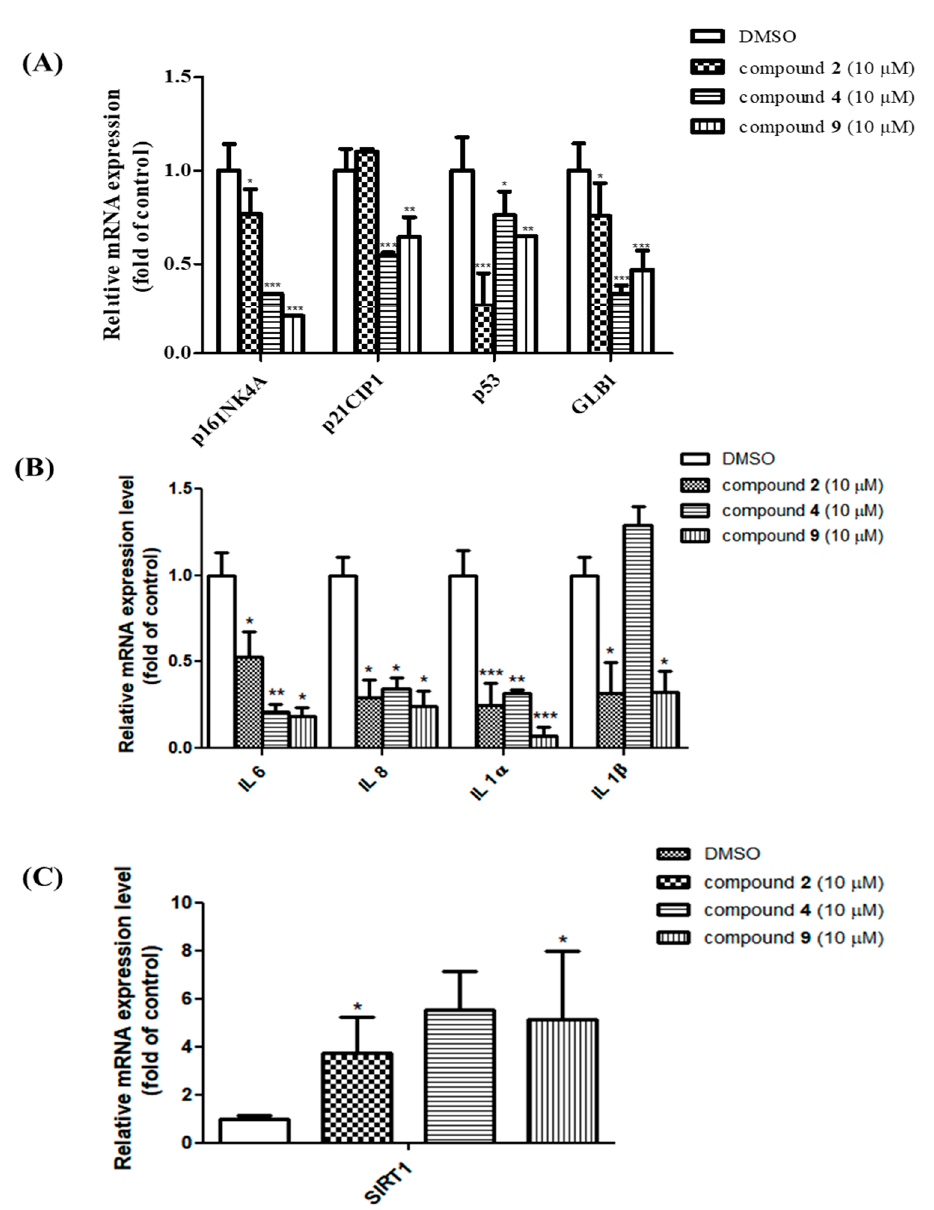
Figure 5. Effects of the isolated compounds on the cell cycle arrest genes, the senescence-associated secretory phenotype (SASP) mRNA expression and the sirtuin 1 (SIRT1) in the senescent human dermal fibroblasts (HDFs). RNA was isolated, and the relative mRNA levels of p16INK4A, p53, p21, SA- β -gal ( A ), SASP ( B ) and SIRT1 ( C ) between the treatment with DMSO and with the 10 µ M compounds 2 , 4 and 9 were determined by qRT-PCR. For data normalization, 18S rRNA was used as an internal control. * p < 0.05, ** p < 0.01, and *** p < 0.001, compared with control.